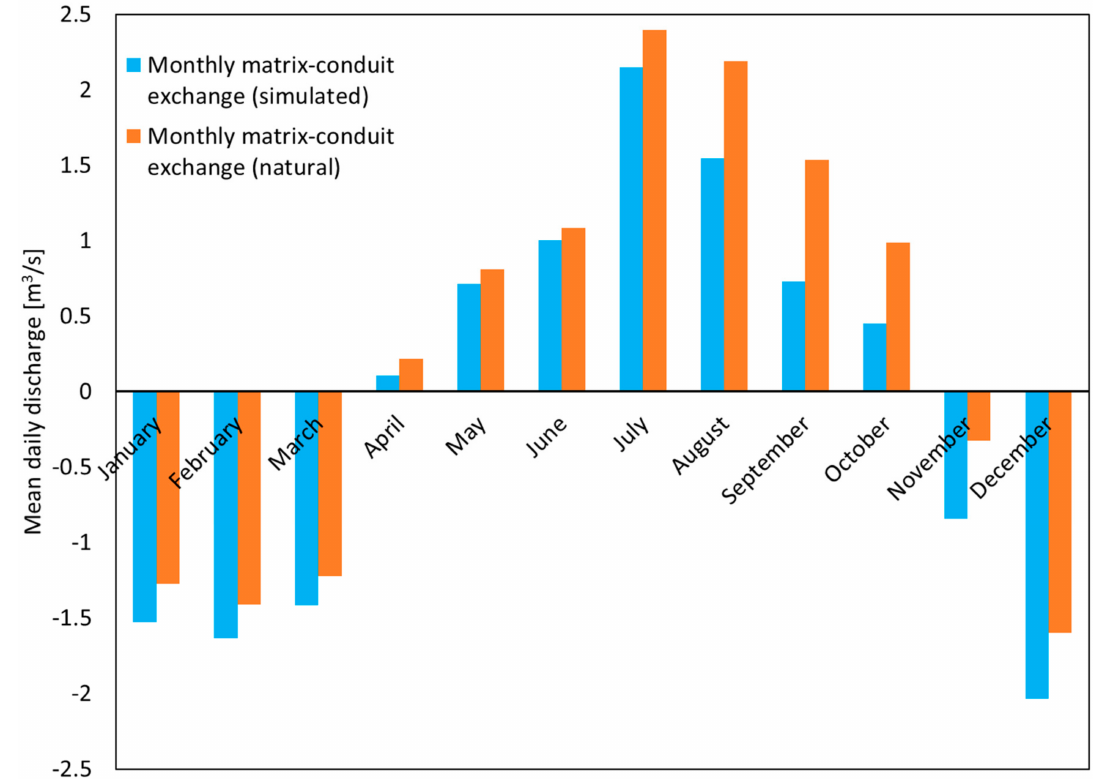
Figure 7. Temporal variability of the impact of the naturalization procedure on the monthly mean matrix–conduit exchange of the calibrated model.